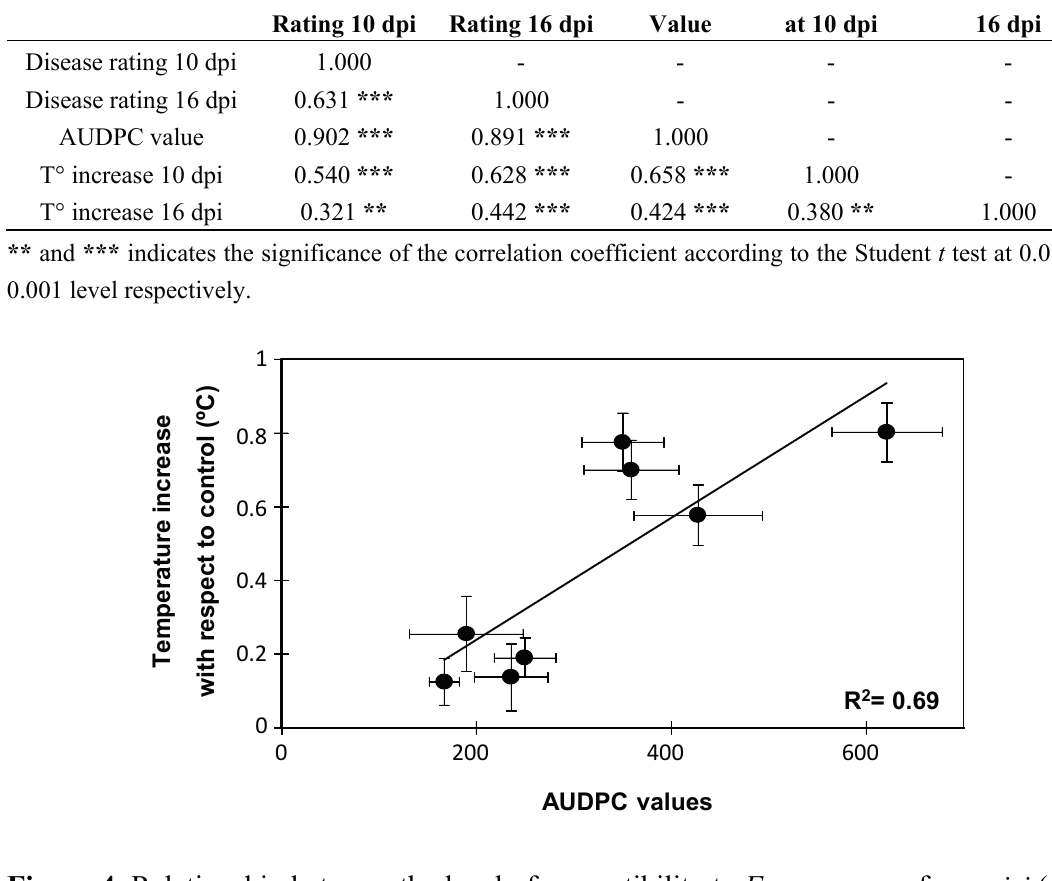
Table 1. Spearman rank correlation coefficient for disease symptom levels and changes in surface leaf temperature comparisons for n = 10. Disease Disease Rating 10 dpi